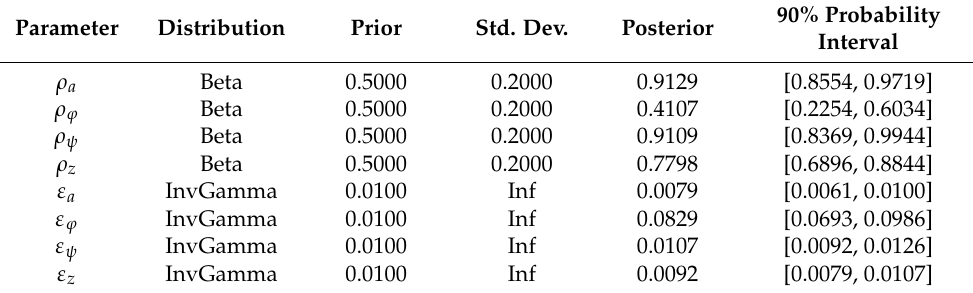
Table 5. Parameter estimations.